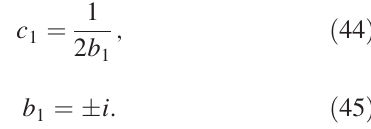
ffiffiffi p 2 . In each case, the red line shows the